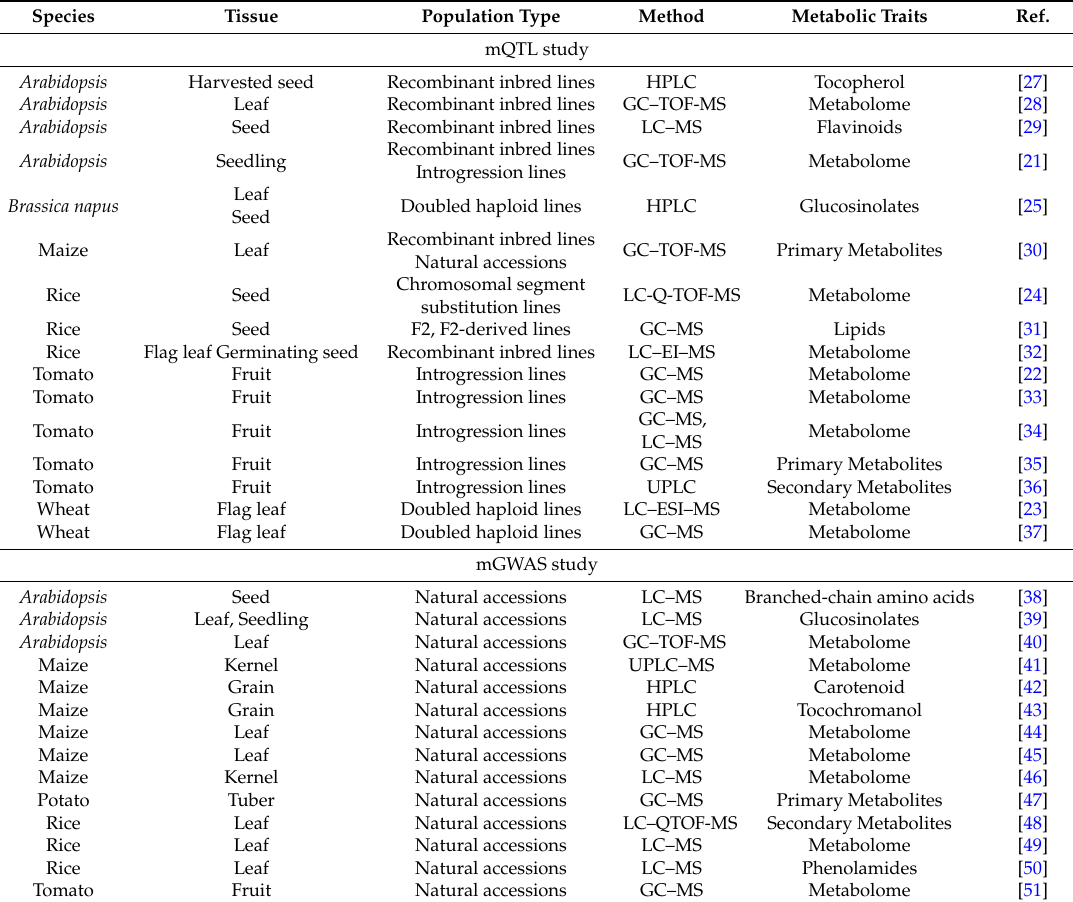
Table 1. Summary of mQTL (metabolite quantitative trait loci) and mGWAS (metabolome-based genome-wide association study) studies in